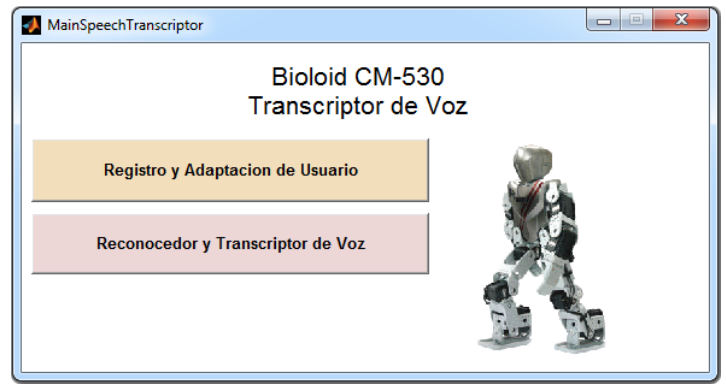
Figure 3. Main interface of the speech-to-text